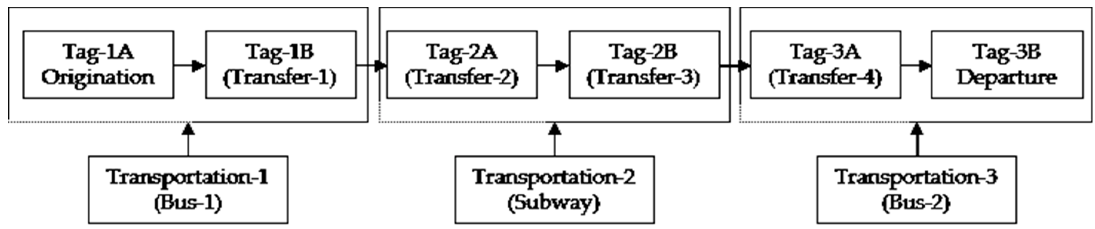
Figure 3. Transaction process of transportation card.